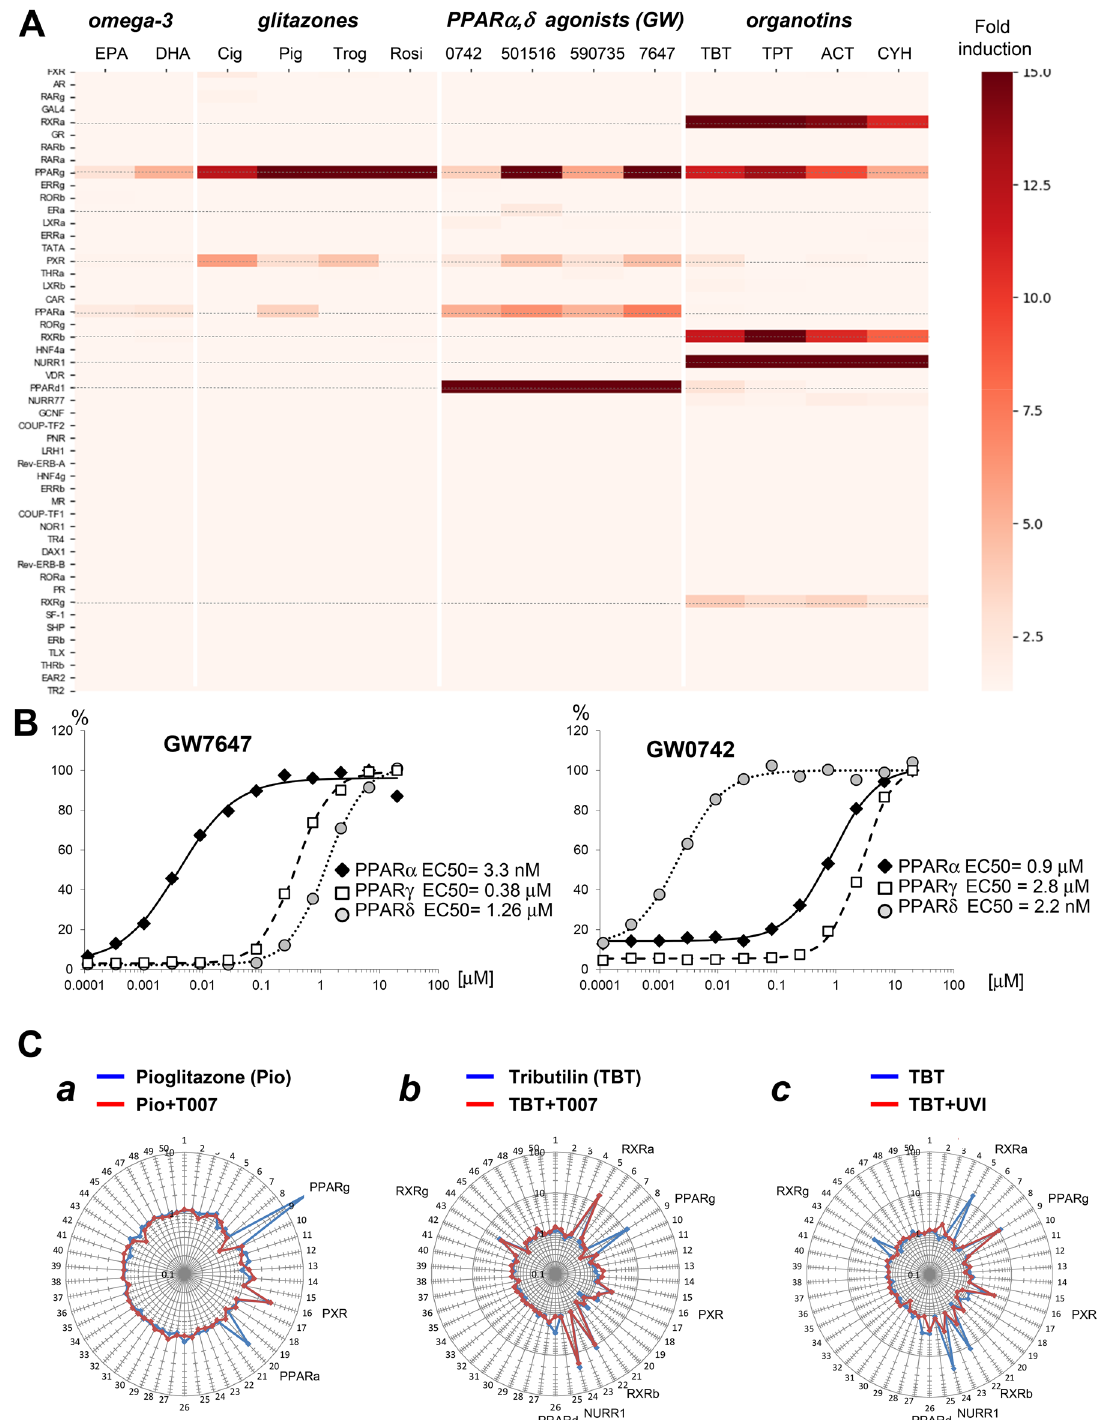
Figure 8. Assessing the polypharmacology of PPAR agonists. (A) NR activity profiles after a 24 h incubation with indicated concentrations of PPAR ligands. The heatmap shows fold-induction NR activity values in stimulated vs. vehicle-treated cells. Each profile is an average of three independent replicate FACTORIAL NR assays. EPA eicosapentaenoic acid; DHA docosahexaenoic acid; Cig ciglitazone; Pio pioglitazone; Trog troglitazone; Rosi rosiglitazone; TBT tributyltin; TPT triphenyltin; ACT azocyclotin; CYH cyhexatin. Organotins were used at 0.1 µM as they were cytotoxic at higher concentrations; all other inducers were at 5 µM. ( B) Concentration–response of PPAR isoforms to PPARα agonist GW7647 and PPARδ agonist GW0742. Average data of three independent replicate FACTORIAL NR assays. ( C) Examining off-target activity mechanisms for PPAR ligands. The blue line graphs show NR activity fold-changes in response to Pio (at 5 µM) ( a ) or TBT (0.1 µM) ( b ), ( c ) vs. vehicle-treated cells. The red line graphs show NR activity profiles for the PPAR ligands in the presence of PPAR inhibitor T0070907 (2 µM) ( a ), ( b ) or RXR inhibitor UVI3003 (2 µM) ( c ) vs. vehicle-treated cells. Average profiles of three independent replicate FACTORIAL NR assays are